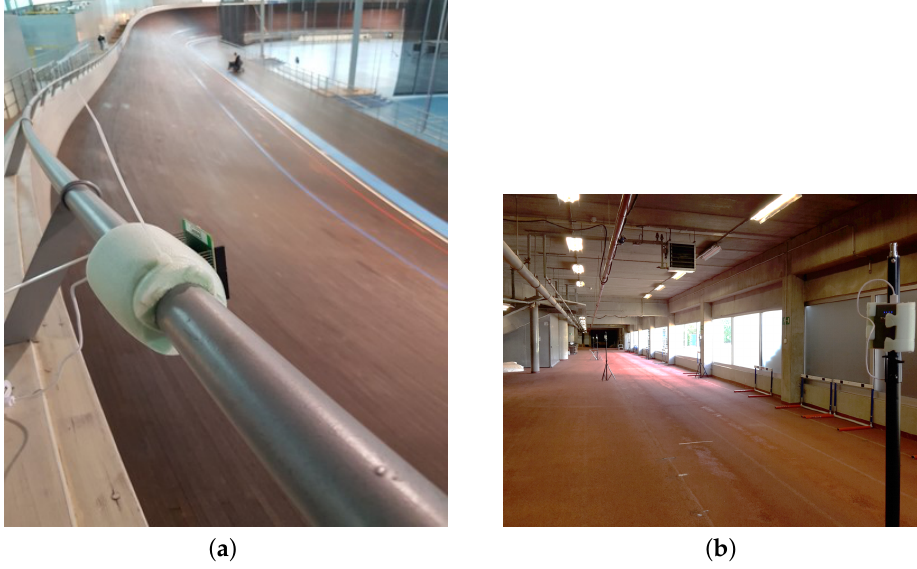
Figure 11. ( a ) Vlaams Wielercentrum Eddy Merckx; and ( b ) the Sports Arena Gent